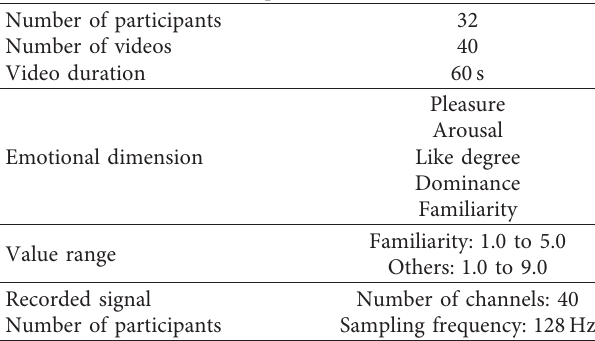
Table 1: Experimental data